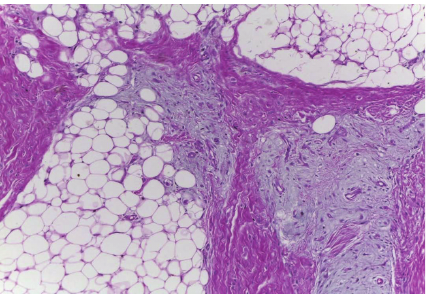
Figure 8: Histopathology of the specimen in Case 2. There was a lobulated mass separated by connective tissue septa consisting of mature adipose tissue, myxoid mesenchymal tissue, and lipoblasts. The myxoid area contains lacy network of small blood vessels (Hematoxylin and Eosin × 100).